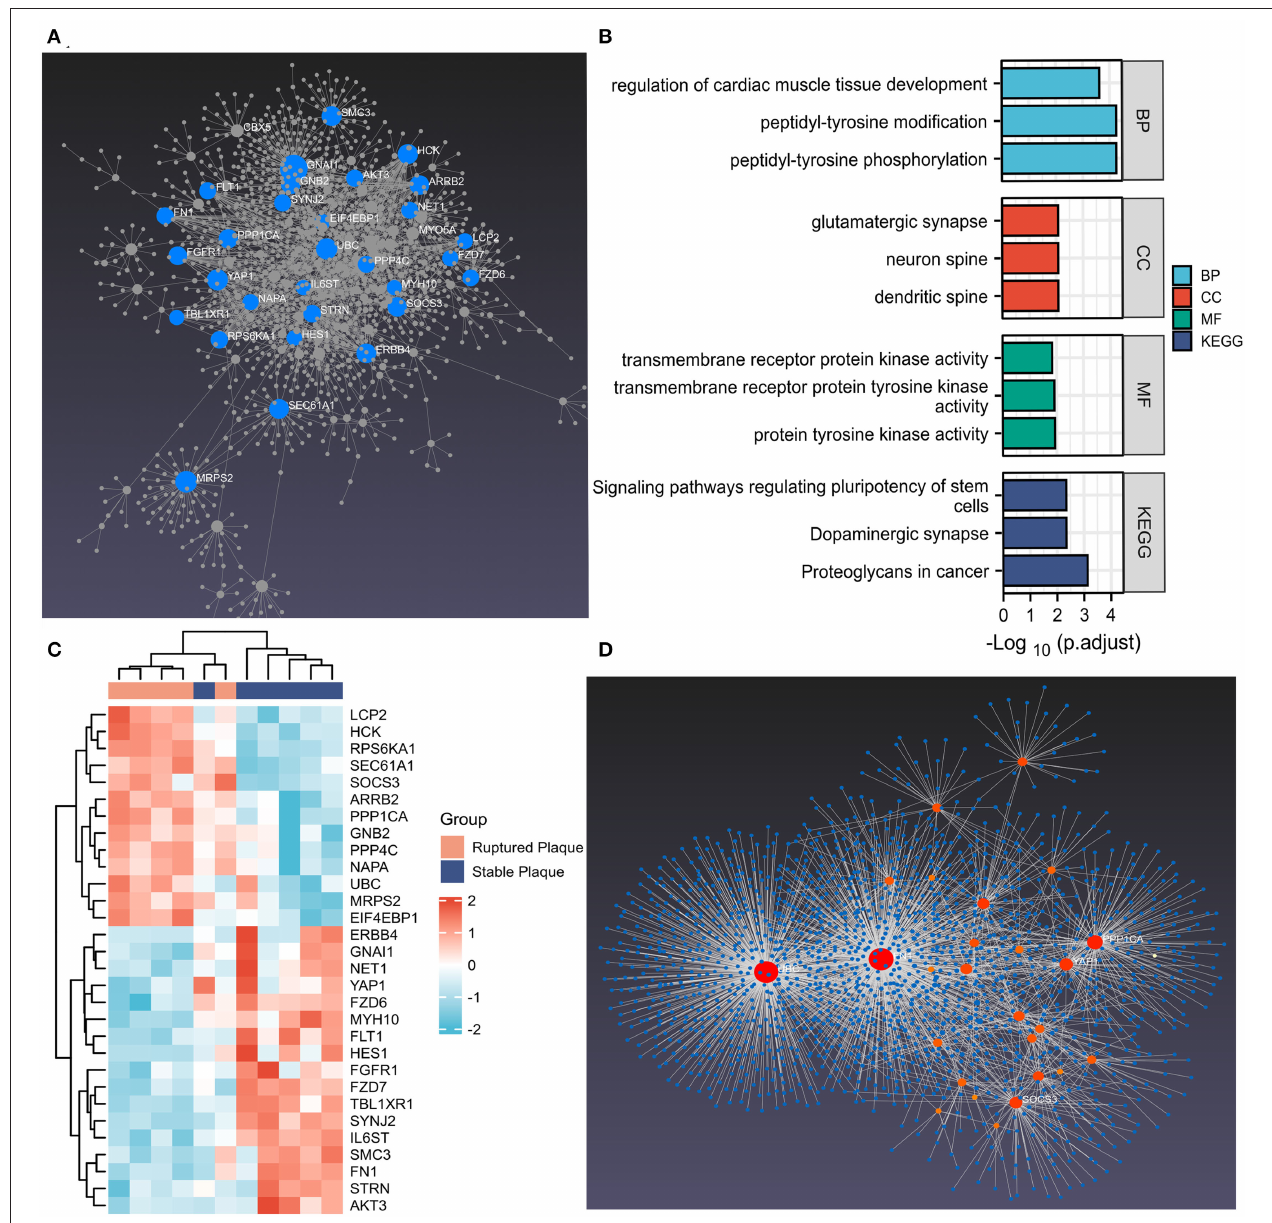
FIGURE 3 | The hub differentially expressed macrophages-related genes (DEMRGs) and enrichment pathway analysis. (A) The hub DEMRGs were shown using NetworkAnalyst 3.0. (B) The significant GO and Kyoto Encyclopedia of Genes and Genomes (KEGG) pathways enriched by the hub DEMRGs. (C) The heatmap of the hub DEMRGs in GSE41571. (D) Left ventricle tissue-specific protein–protein interactions (PPIs) were applied, demonstrating UBC, FN1, PPP1CA, YAP1, and SOCS3 were core regulators in the